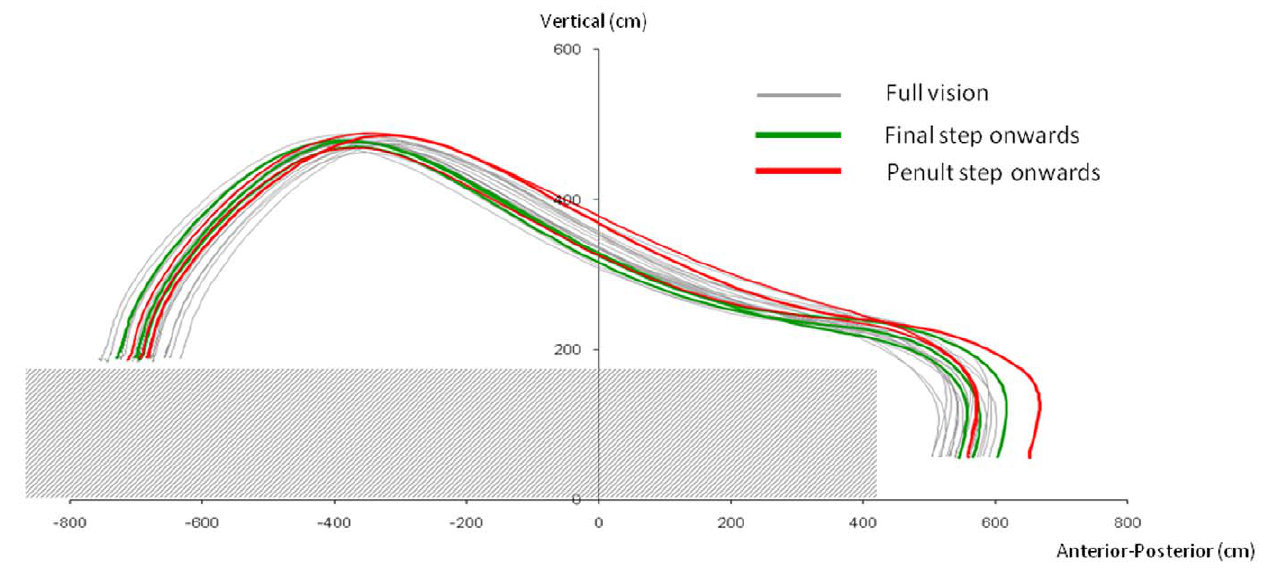
Figure 3. Lower visual field influence upon heel trajectory. Trajectories of the heel marker are shown for all trials from one subject for the step onto the lower floor level. Trajectories are plotted from lead-limb toe-off up to instant of contact with the lower level. NB, the heel trajectory for the condition when lvf was occluded at instant of penultimate step contact onwards, was beyond or towards the upper part (indicating higher heel clearance) of the variability boundaries of the full vision available throughout condition.